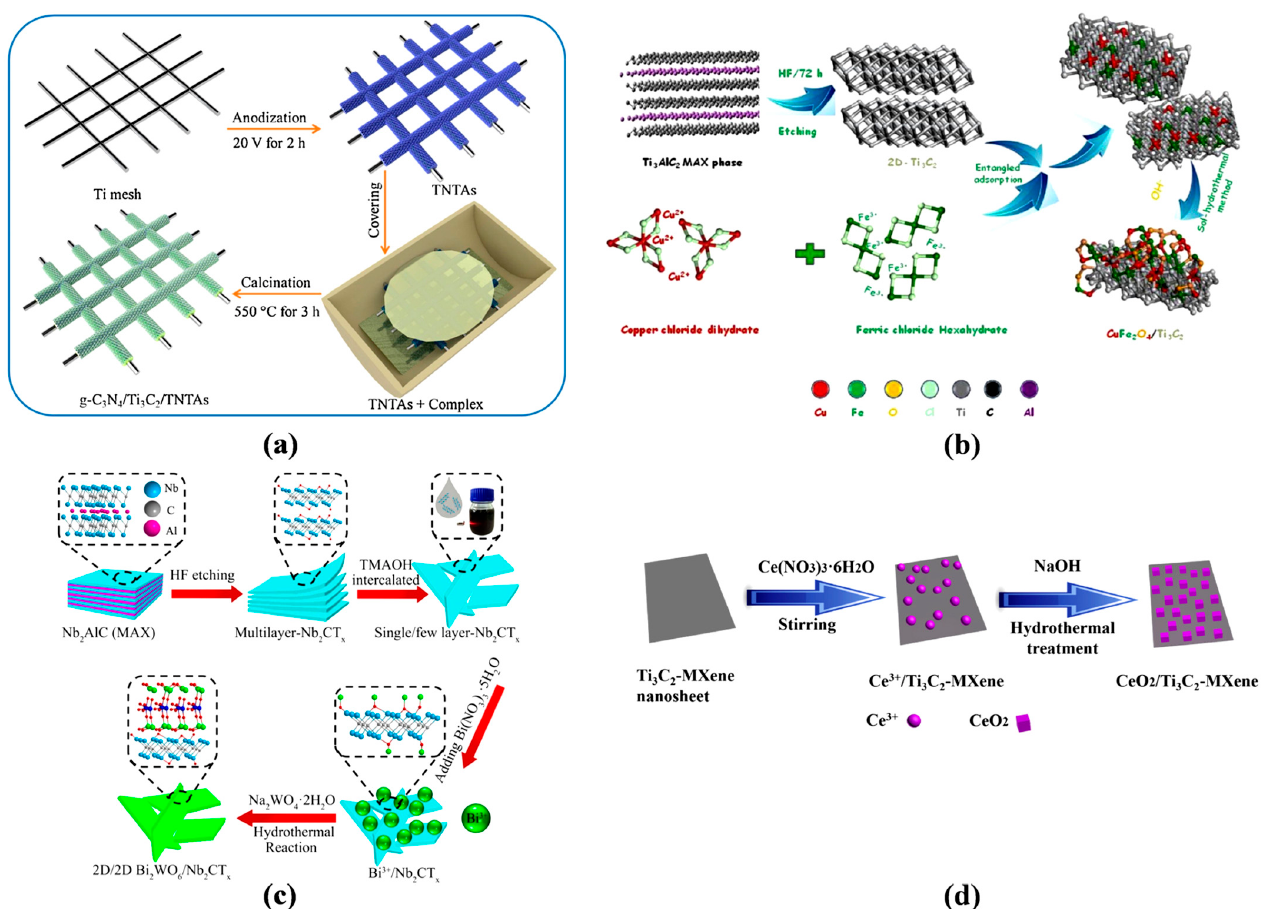
Figure 6. Schematic explanation of the synthesis methods of ( a ) g-C 3 N 4 /Ti 3 C 2 /TNTAs, ( b ) CFO/Ti 3 C